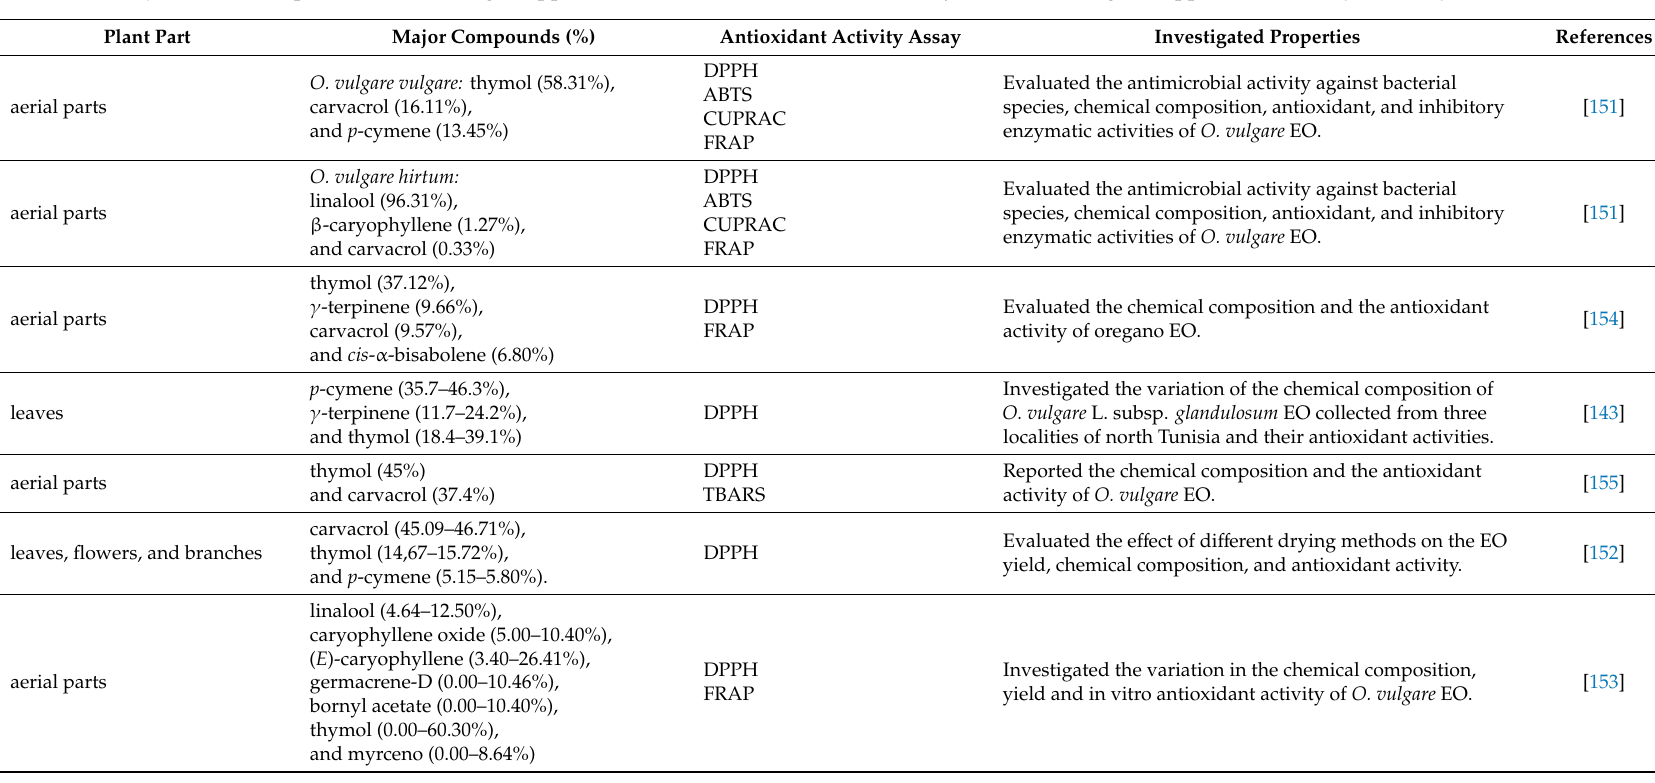
Table 4. Major natural compounds, methodologies applied to determine the antioxidant activity, and the investigated applications of Origanum vulgare (Lamiaceae)